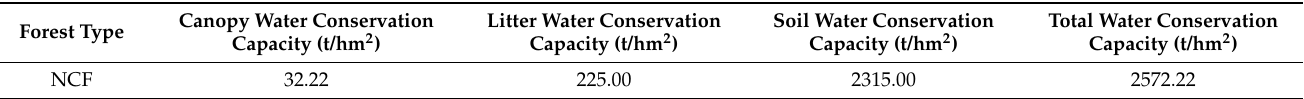
Table 3. Hydrological characteristics of NCF in the Upper Zagunao watershed